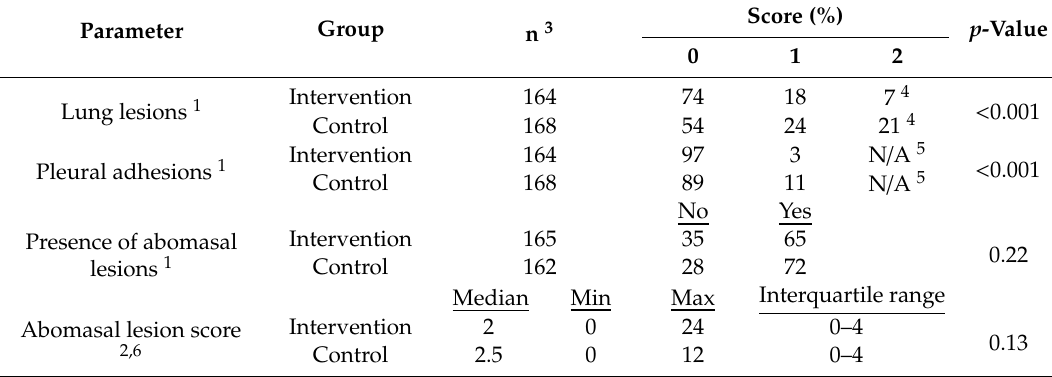
1 Analyzed using Chi-Square test. 2 Analyzed using Mann-Whitney-U test. 3 n = number of observations. 4 Original score 3 was merged with score 2 due to observation counts between 0 and 1. 5 N / A, not applicable; pleural adhesions were recorded as present or not. 6 For a definition of abomasal lesion score, see Table 4. The level of significance was set at p ≤